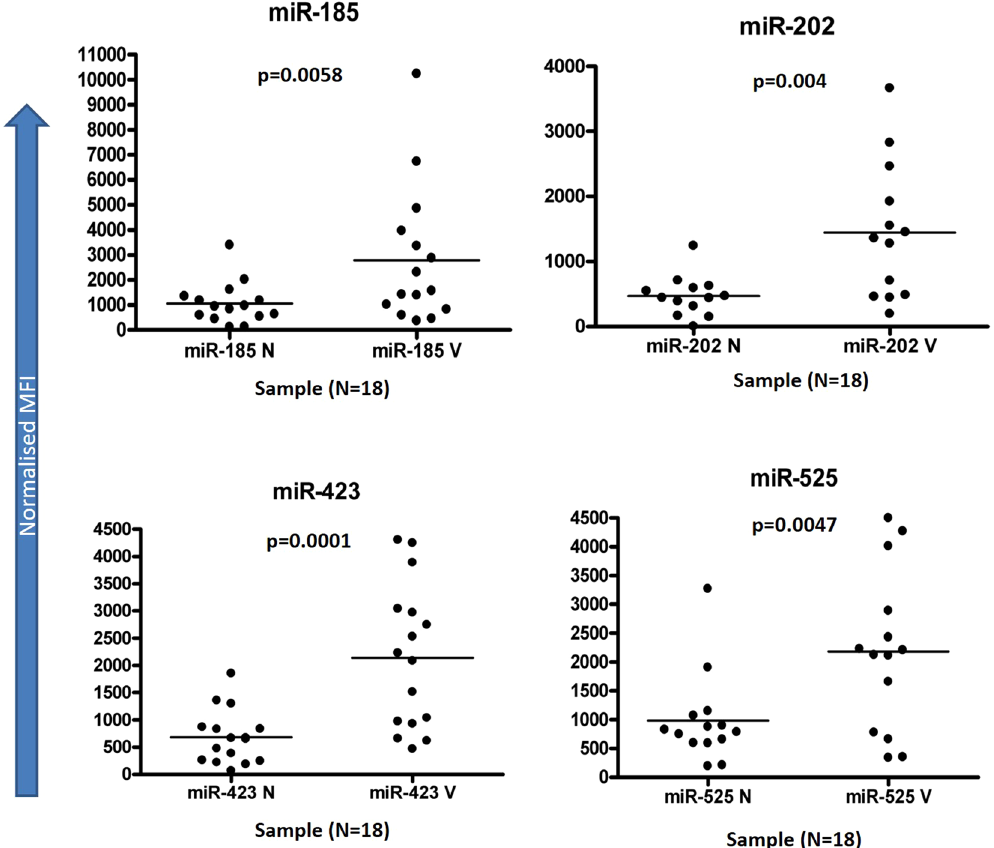
Figure 1. Expression of micro RNAs miR-185, miR-202, miR-423, & miR-525 in Vitiligo: Scatter-plots showing the expression of miR-185, miR-202, miR-423, and miR-525 in lesional and non-lesional epidermis of 18 vitiligo patients. On, X axis the suffix N denotes non-lesional epidermis, while V denotes the vitiligo lesional epidermis. Values plotted are the background-subtracted, normalised Mean Fluorescence Intensity (MFIs).